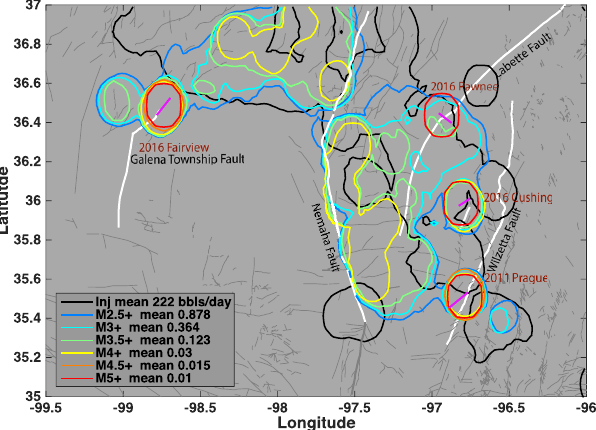
Figure 1. Map view of event density distribution for different sized earthquakes and injection rates. Colored lines show the contour lines of average number of events for each magnitude range (see Legend). Gray lines show mapped faults from OGS database 86 . The major faults are labeled and shown in white thick lines. Thick purple lines denote the seismogenic faults for the four M5 + earthquakes delineated from earthquake locations. Each contour line represents spatial grids that have number of events larger than the average number of events per smoothed bin within the magnitude threshold. Individual density map is shown in Figure S1. The three M5 + sequences are well located at the edge of the seismic zones. The black contour line shows the spatial grids that have average injection rate from 2011 to 2016 higher than the average injection rate per smoothed bin. The figure is generated with Matlab 2015a, available at: